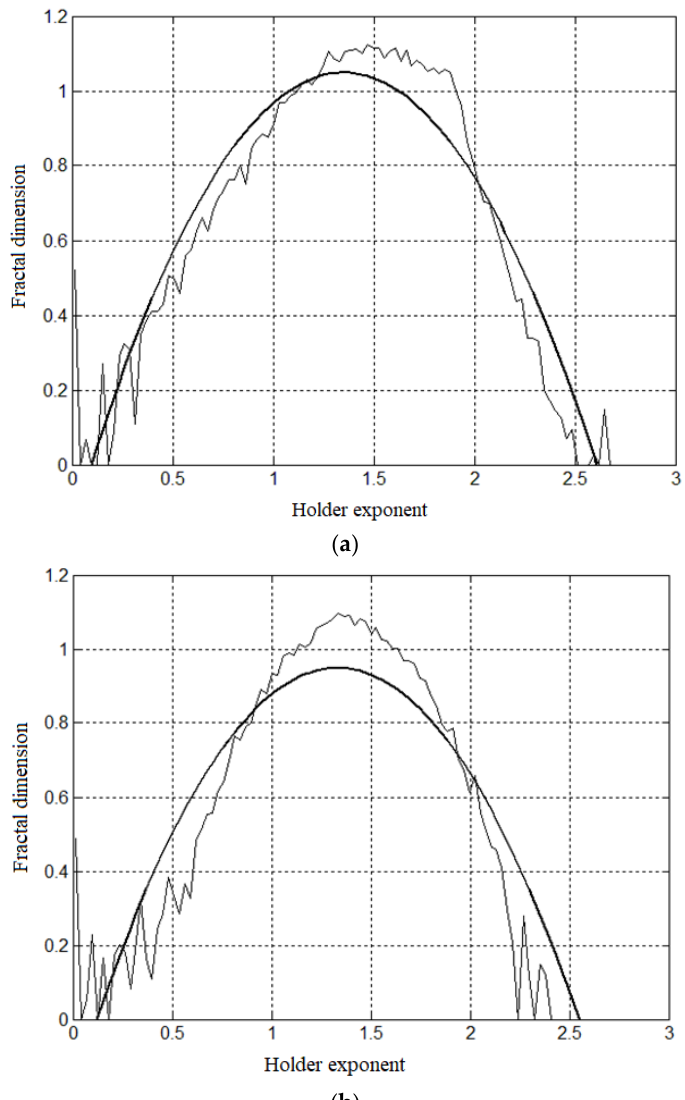
Figure 7. Multifractal spectra (Algorithm Steps 3.2 and 3.3): ( a ) — MPI-1; ( b ) — MPI-2. The multifractal spectra of Figure 7 are used to calculate generalized fractal dimen- sions (Algorithm Step 4.2 and Stage 6): , D D D , the graphs of which are shown in Figure 8.